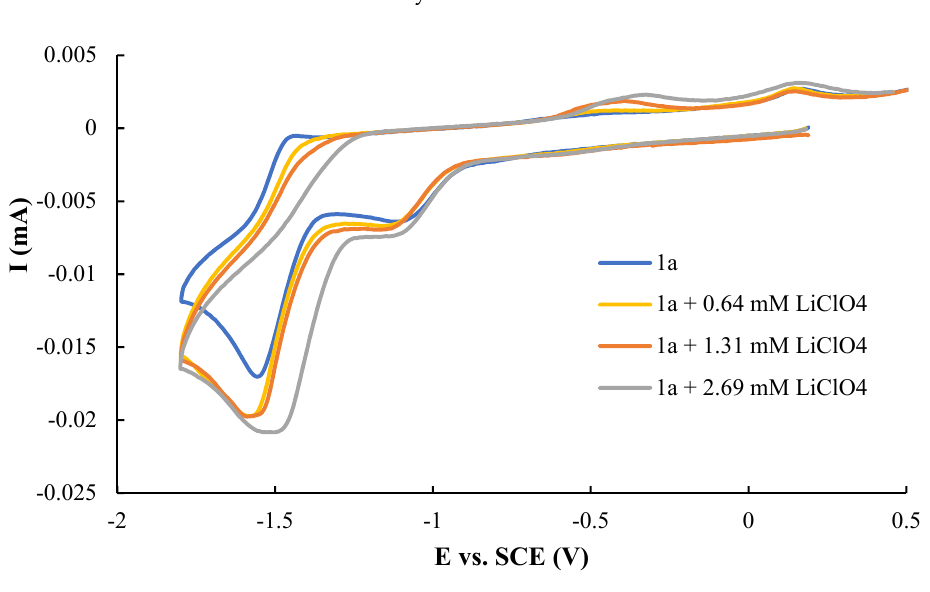
Figure 9. CVs of a 1.3 mM solution of 1a in the presence of LiClO 4 , v = 0.1 Vs − 1 .